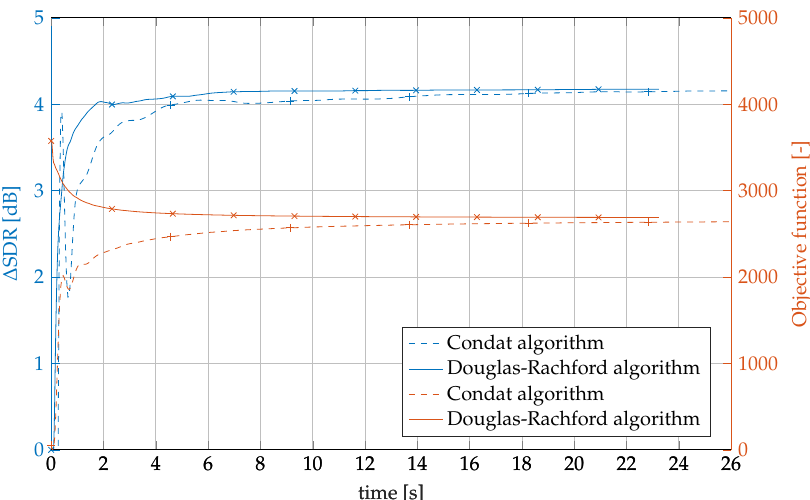
Figure 2. Development of the ∆ SDR (blue) and objective function (orange) through iterations for the particular “acoustic guitar” excerpt and the clipping threshold θ c = 0.3. Both algorithms ran for a fixed number of 1000 iterations here. To demonstrate the time differences between the algorithms, every 100th iteration is emphasized with a marker ( + for Condat and × for Douglas–Rachford).